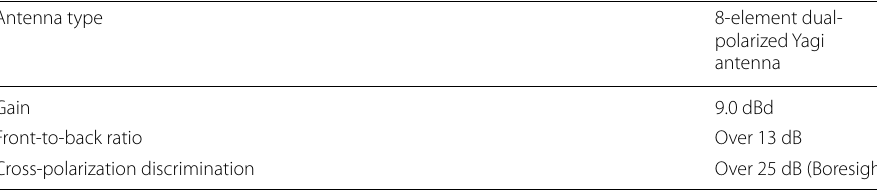
Table 3 Specifications of receiving